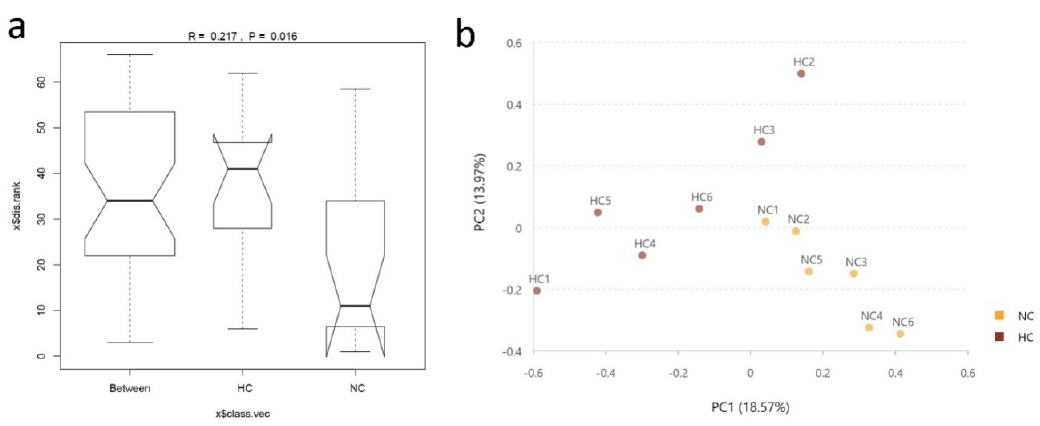
Figure 2. Similarity of intestinal bacterial community of goats fed NC and HC diets. ( a ) Analysis of similarities (Anosim) in the ileal bacterial community. ( b ) Principal component analysis (PCA) of ileal digestal bacterial community. Table 3. Phylum-level composition (%) of the ileal bacterial community of twelve goats fed normal- concentrate (NC) and high-concentrate (HC)